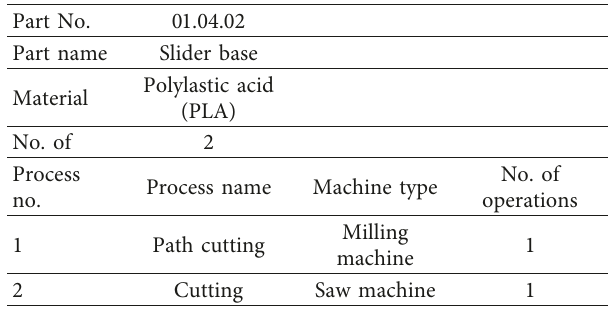
Table 8: Base of the slider.